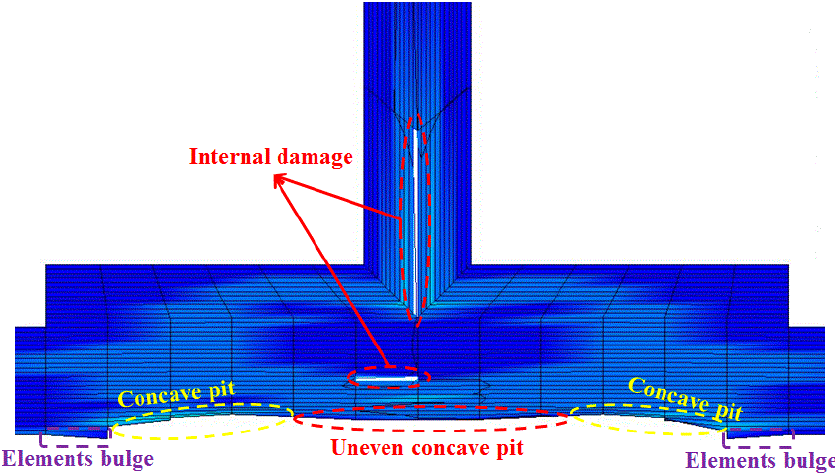
Figure 12. Damage forms in the cross-section of the composite reinforced panel.